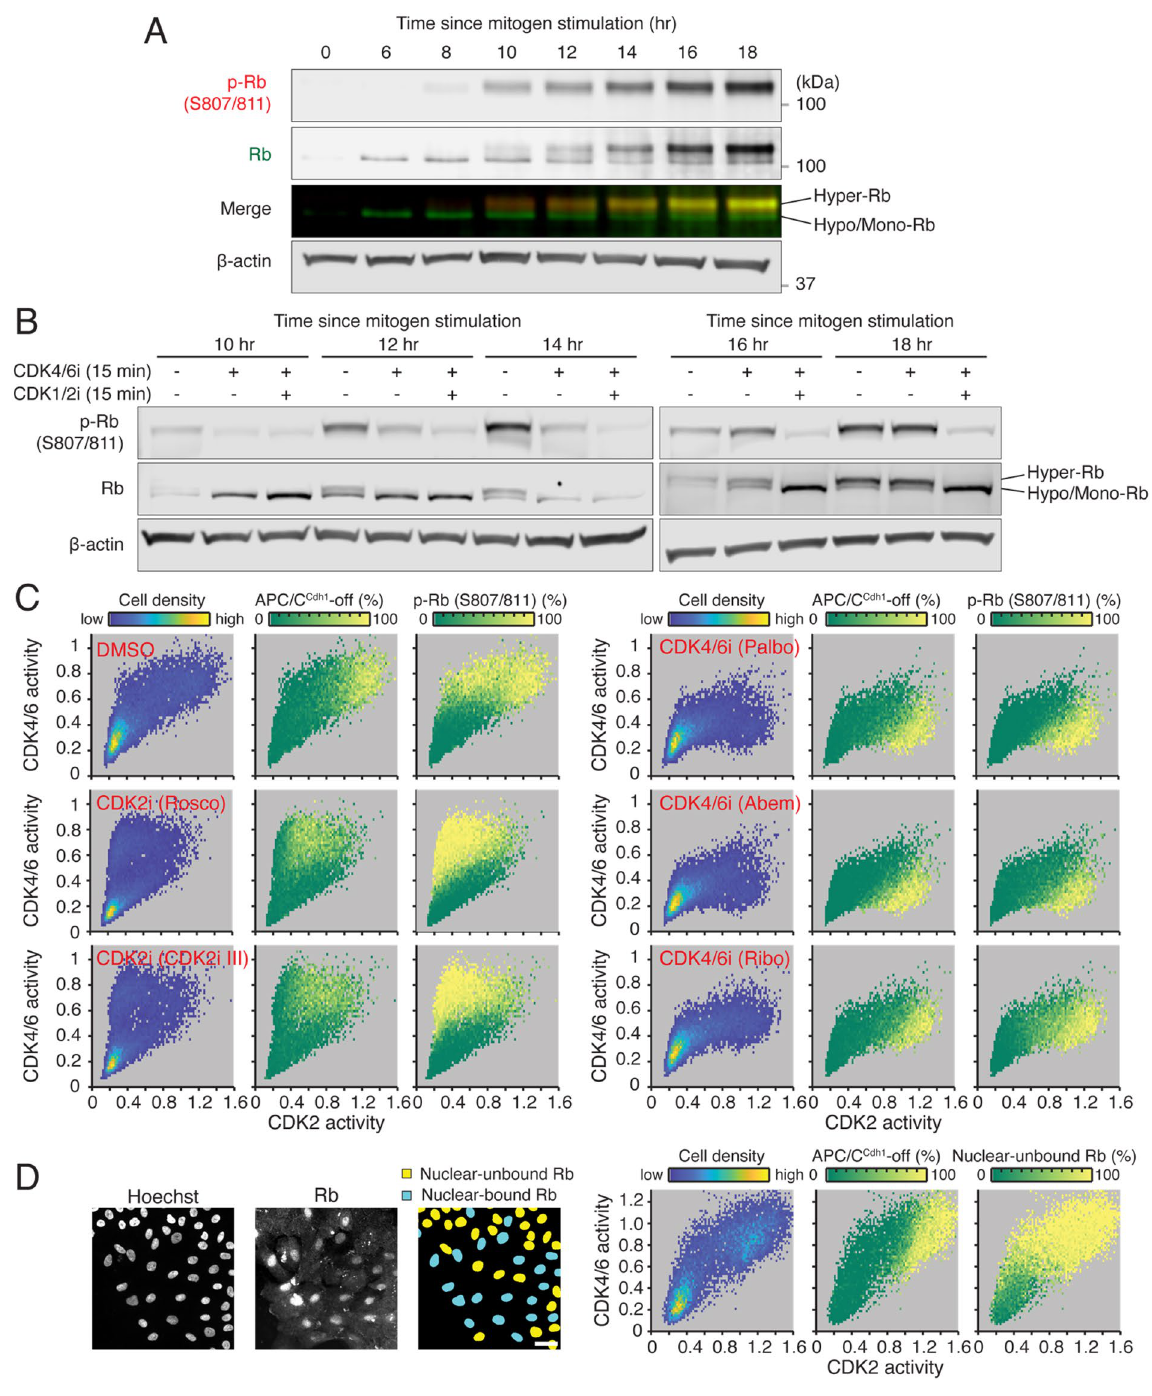
Figure 2. CDK4/6 activation induces Rb hyperphosphorylation and inactivation. ( A , B ) Immunoblot of p-Rb (S807/811), total Rb, and β-actin in MCF-10A cells at various time points after mitogen stimulation. After 48 h mitogen removal, MCF-10A cells were stimulated with mitogens for indicated time and then treated with DMSO, palbociclib (1 µM), or palbociclib (1 µM) + CDK1/2 inhibitor III (1 µM) for 15 min prior to harvesting cells ( B ). ( C ) Three-dimensional activity maps of CDK4/6 versus CDK2 activity where cell density, the percentage of inactivated APC/C Cdh1 , and the percentage of p-Rb at sites S807/811 are color-coded. After 48 h mitogen removal, MCF-10A cells were stimulated with mitogens for 12 h and treated with DMSO, roscovitine (60 µM), CDK2 inhibitor III (60 µM), palbociclib (1 µM), abemaciclib (1 µM), or ribociclib (1 µM) for 1 h prior to fixation. ( D ) Left, representative images of nuclear-bound Rb after in situ extraction and classification of nuclear-bound and nuclear-unbound Rb. Scale bar is 20 μm. Right, three-dimensional activity maps of CDK4/6 versus CDK2 with corresponding cell density, the percentage of inactivated APC/C Cdh1 , and the percentage of nuclear-unbound Rb color-coded (left to right). After 48 h mitogen removal, MCF-10A cells were stimulated with mitogens for 12 h prior to in situ extraction and